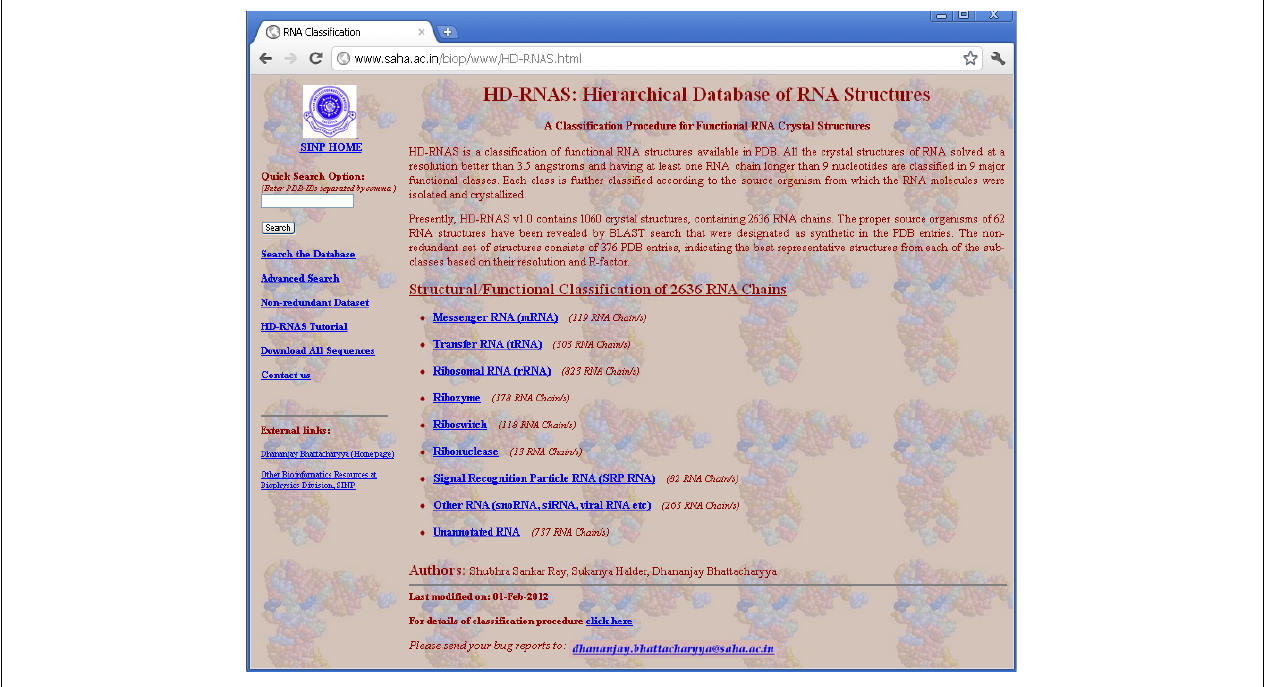
FIGURE 1 | HD-RNAS